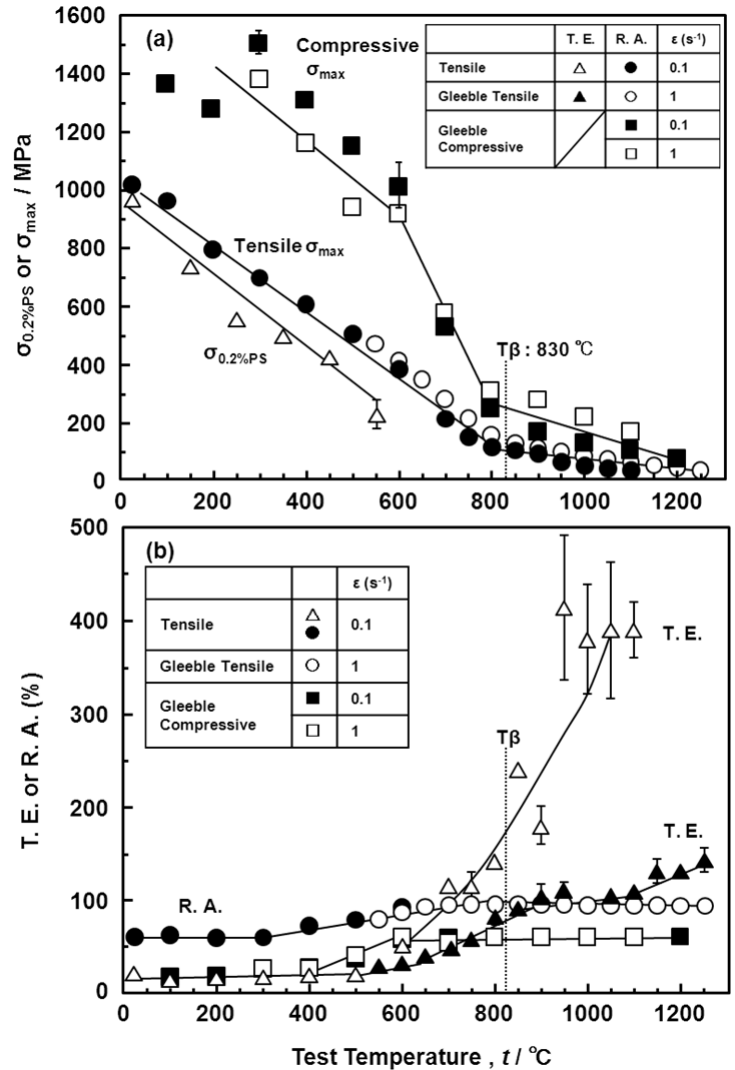
Figure 16. Effects of test temperature on high-temperature mechanical properties ( σ , T.E. and σ max